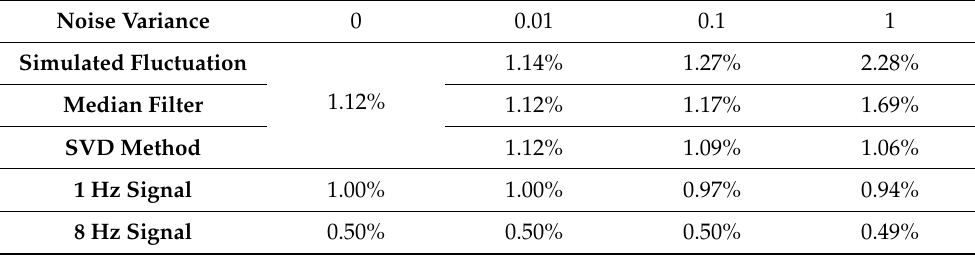
Table 6. Simulation result of superimposed